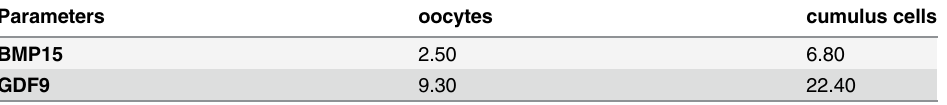
Table 1. The impact of VHT on the changes in BMP15 and GDF9 expression in both generations of female rabbits (FC VHT-M / FC VHT-F1 ).